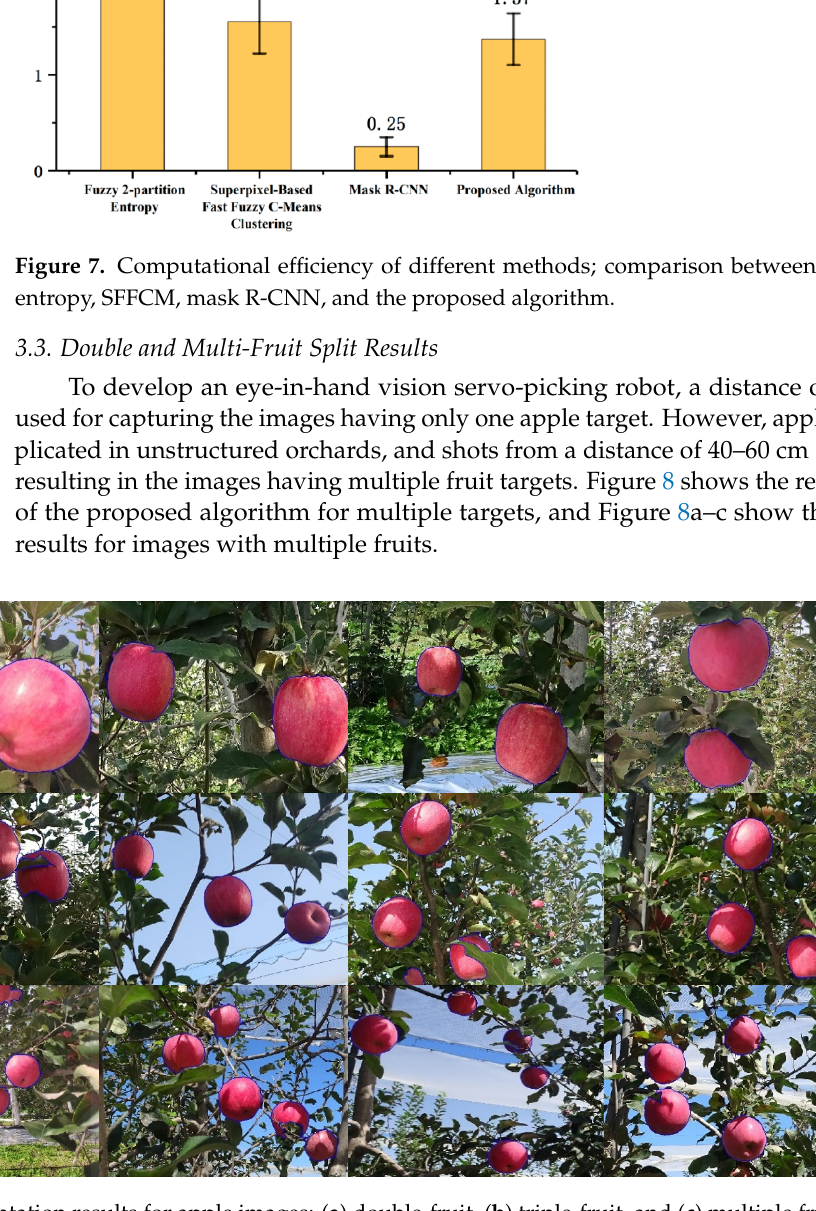
Figure 6. Experimental comparison of different methods: fuzzy 2-partition entropy, SFFCM, mask R-CNN, and the pro- posed algorithm.